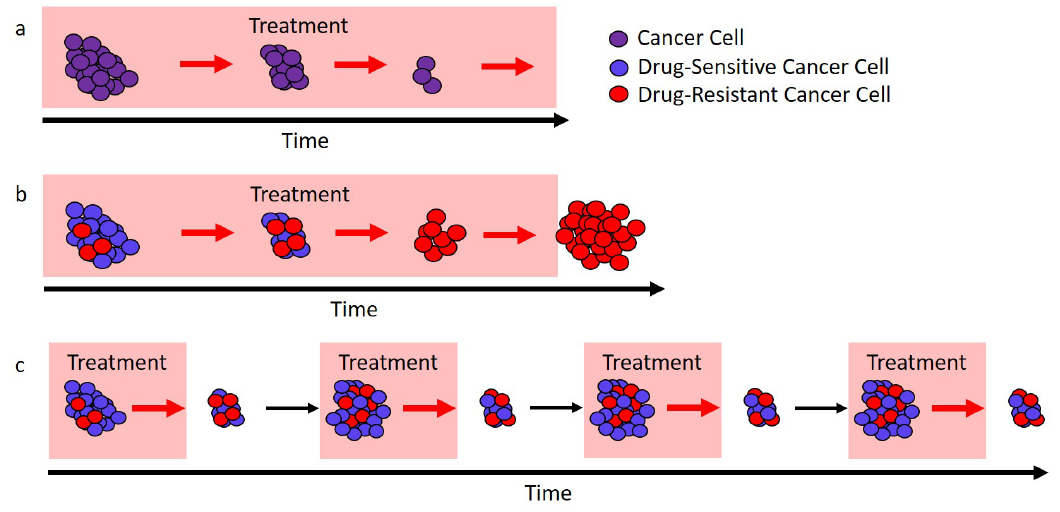
Figure 1. Different approaches to treatment. ( a ) In ideal circumstances, continuous treatment (here, called the “standard of care”) will stop tumor cell growth and lead to cure. ( b ) If there are drug-resistant cells (red), the standard of care can only remove the drug-sensitive cells (blue), and this leaves a fully resistant tumor that can expand in size. ( c ) If treatment is modulated so that not all drug-sensitive cells (blue) are removed, then these cells can competitively suppress the expansion of the resistant cells (red). In ideal circumstances, this would lead to longer tumor